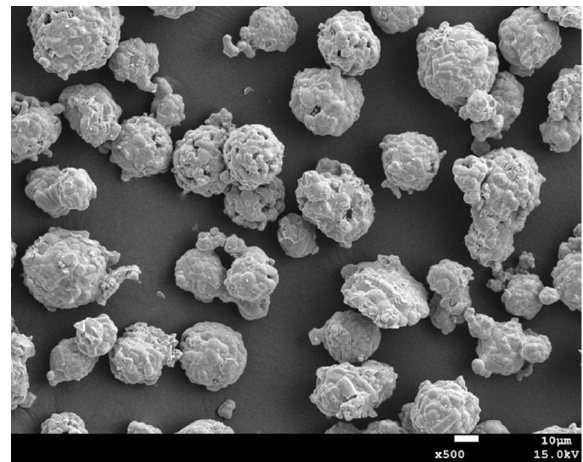
Figure 3. The SEM images of RP [56].